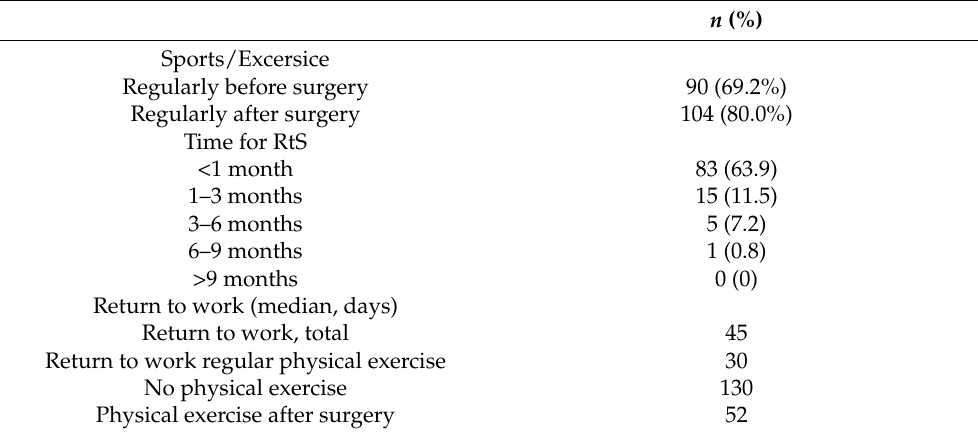
Table 10. Status of sports, RtS (return to sports) and RtW (return to work).